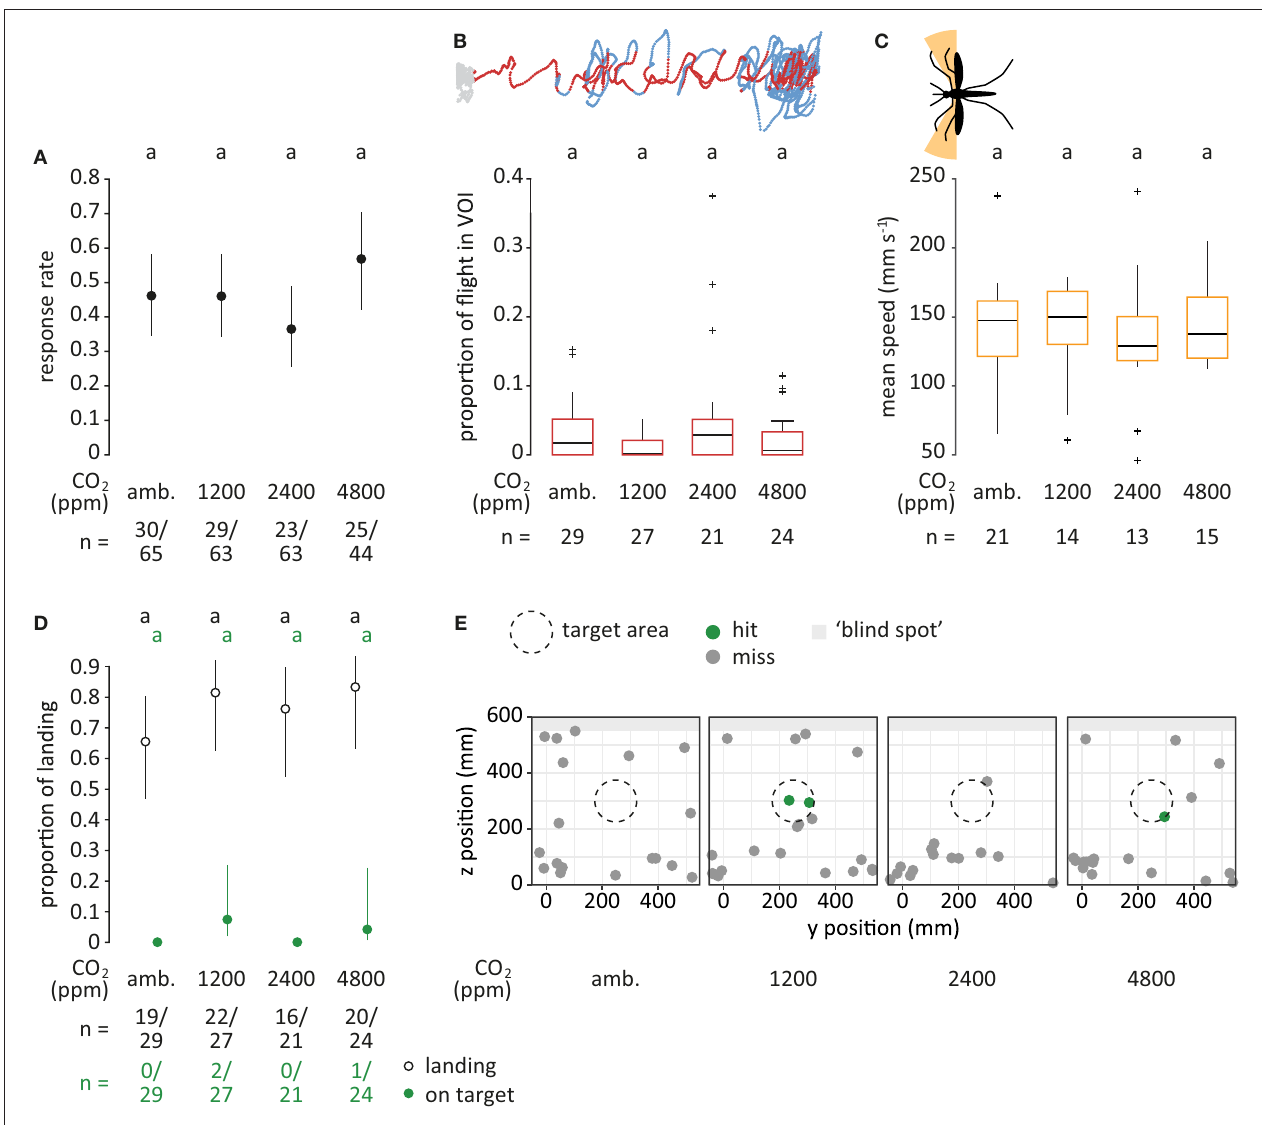
FIGURE 5 | Mosquito flight in response to different concentrations of carbon dioxide. (A) Proportion of mosquitoes responding (dots), i.e., entering the filmed volume within 3min, for each treatment. “amb.” for ambient. Bars denote 95% confidence intervals. Different letters denote significant differences between the treatments (pairwise comparison using ‘emmeans,’ corrected with the Tukey method). Sample sizes are given below the plot. (B) Proportion of flight in volume of interest (VOI), as shown in dark red in the top panel (see Figure 3C ). Boxes represent upper and lower quartiles, whiskers denote 1.5 times interquartile distance, crosses outliers, and black horizontal lines the median. Different letters denote significant differences between the treatments (Dunn Kruskal-Wallis pairwise comparison test, Benjamini-Hochberg corrected). (C) Mean speed of crosswind flight for heading angles between 90 ◦ to 120 ◦ and 240 ◦ to 270 ◦ (orange area in the top panel). Only mosquitoes that were within the VOI at least once were taken into account. (D) Proportion of mosquitoes landing (black, open) and of mosquitoes landing on target (green, filled) relative to the total number of responsive mosquitoes. In treatments where no mosquitoes landed on target, CIs were infinite and thus not shown. (E) Landing location on the upwind screen. The defined target area (ø 15cm) is denoted as a dashed circle. Green dots indicate landing positions within, and gray dots positions outside of the target area. Light gray area denotes the “blind spot” where tracking of landing was not possible.